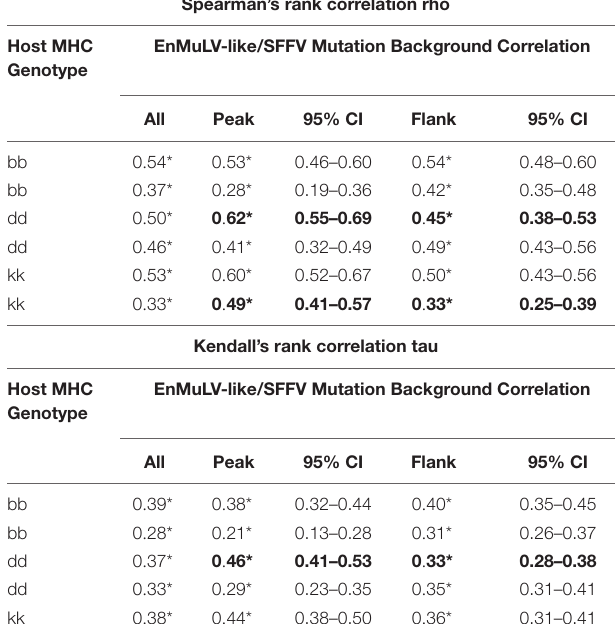
TABLE 1 | Spearman and Kendall rank correlations of EnMuLV background mutations. Spearman’s rank correlation